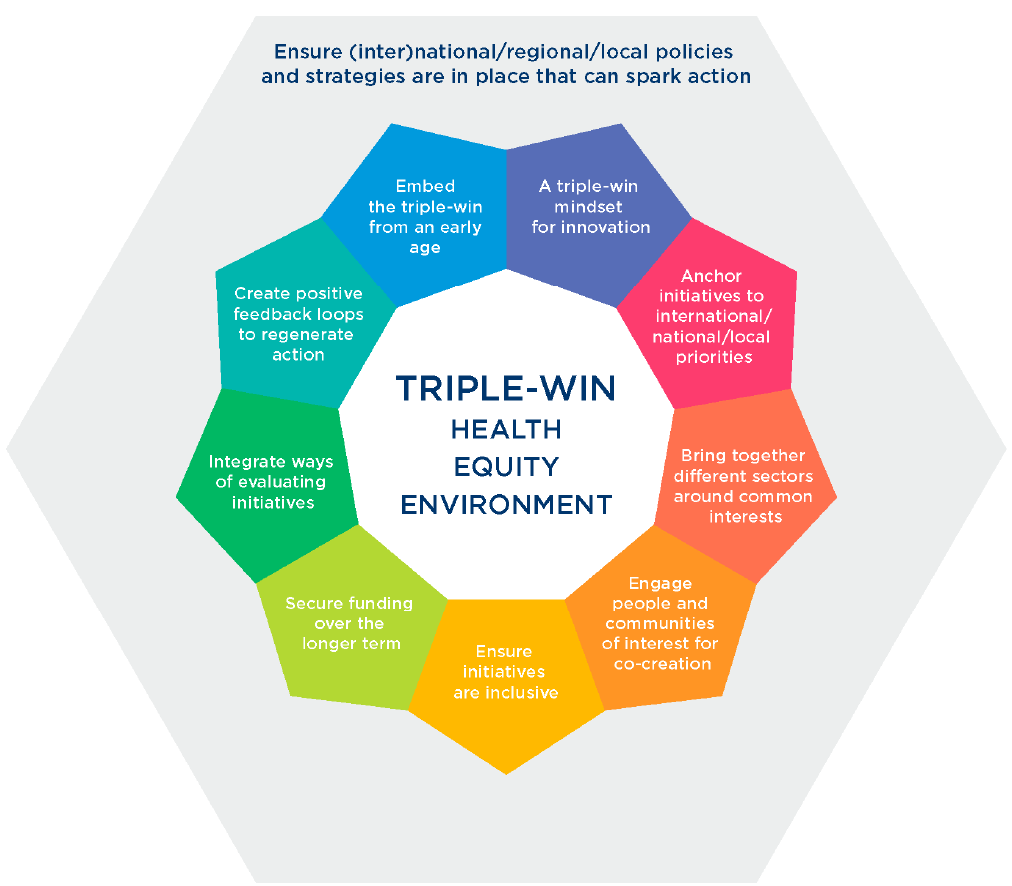
Figure 2. Overarching lessons for good practice for the INHERIT triple win.